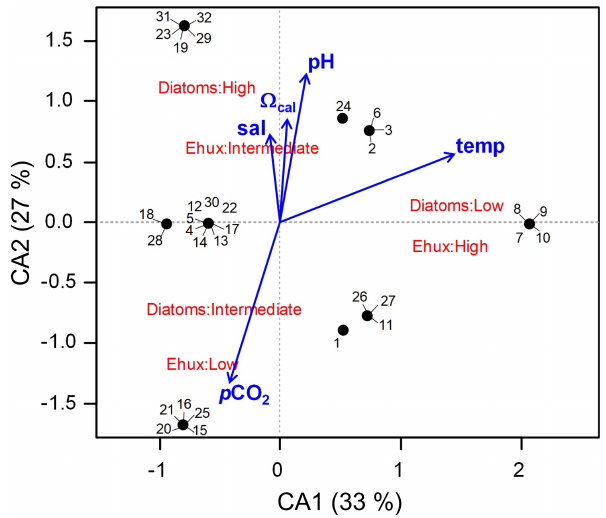
Figure 8. Correspondence analysis (CA) assessing the relationship between E. huxleyi and diatom biomasses converted to categoric values (i.e., low, intermediate, and high biomasses) in Patagonia fjords during late spring 2015 and early spring 2017. The envit function of the vegan package (R software) was used to fit the en- vironmental variables to the CA plot (no variable was significant; p > 0 .